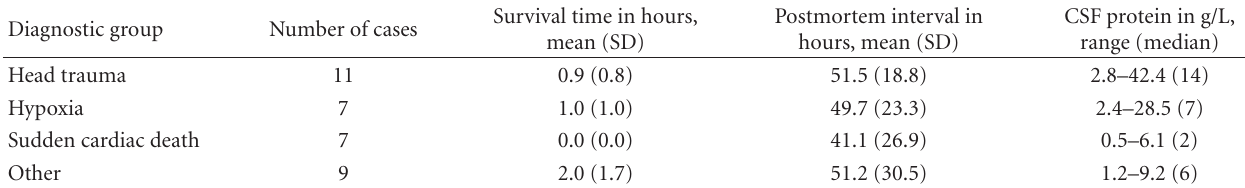
Table 4: Data from Osuna et al